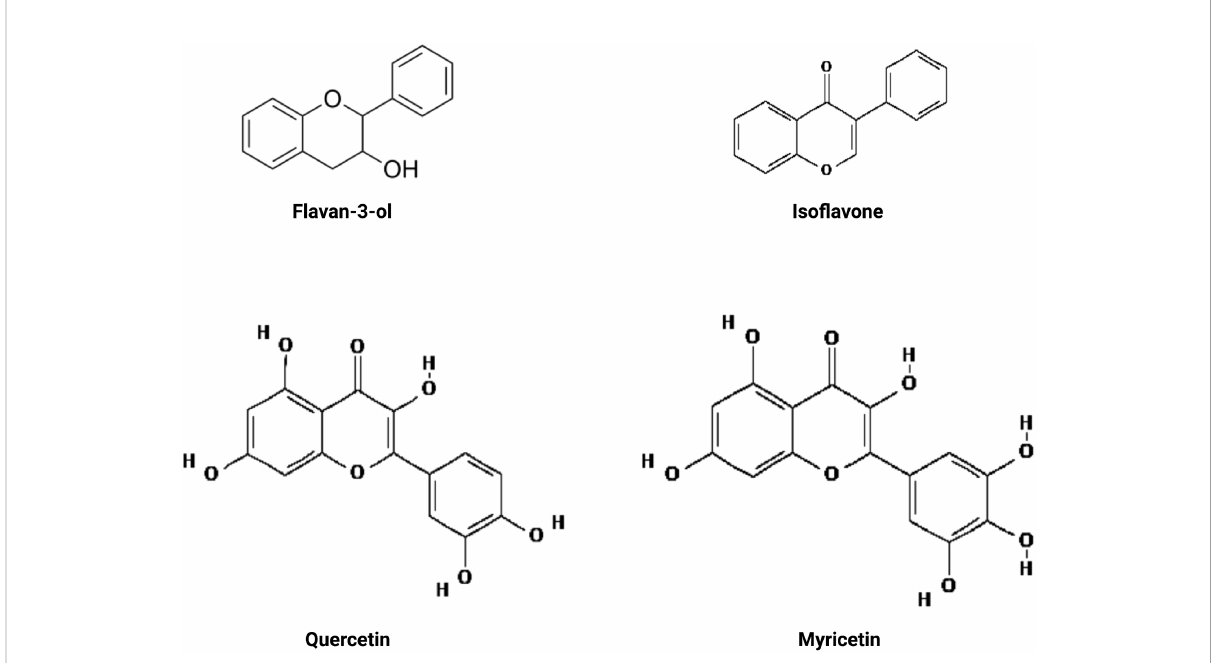
FIGURE 6 Flavonoids exhibiting an association with a reduced risk of type 2 diabetes mellitus in clinical